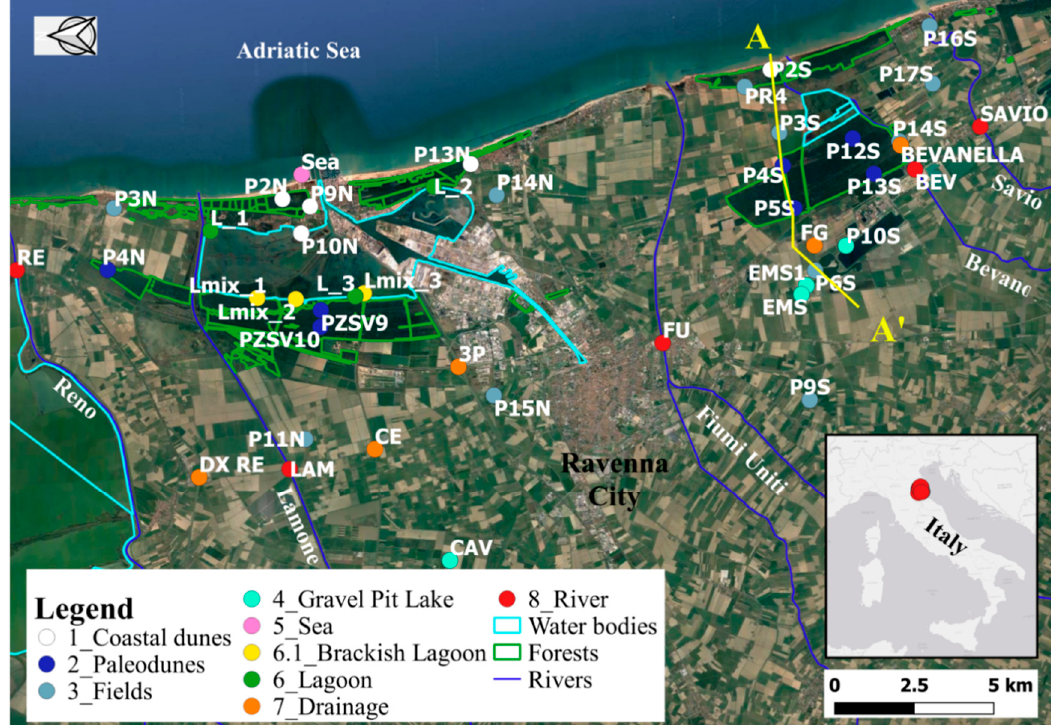
Figure 1. Location of surface and groundwater sampling points grouped by environment as classified by Mollema et al., 2013 [53]. Transect A-A’ indicates the geological section shown in Figure 2. Background is a Google satellite by QuickMapService QGIS plugin.